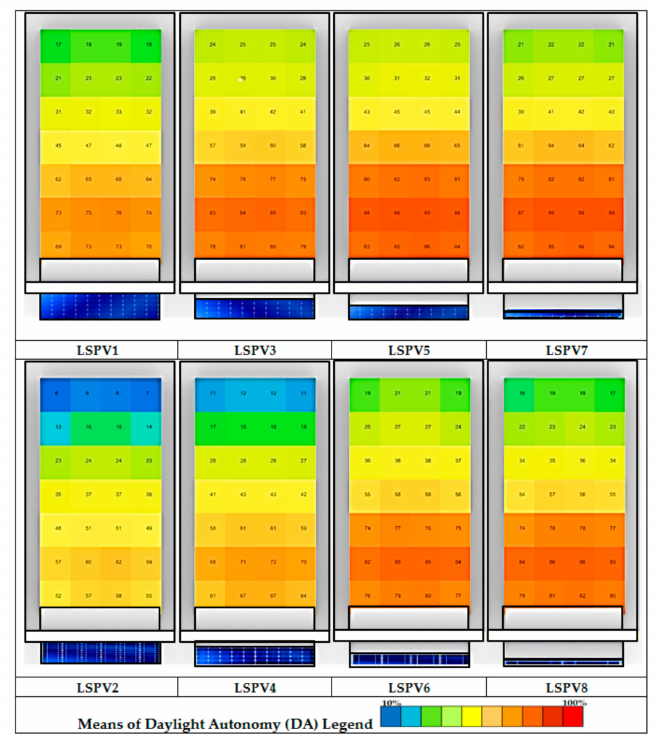
Figure A2. Daylight autonomy (DA) distribution of di ff erent LSPV configurations in each